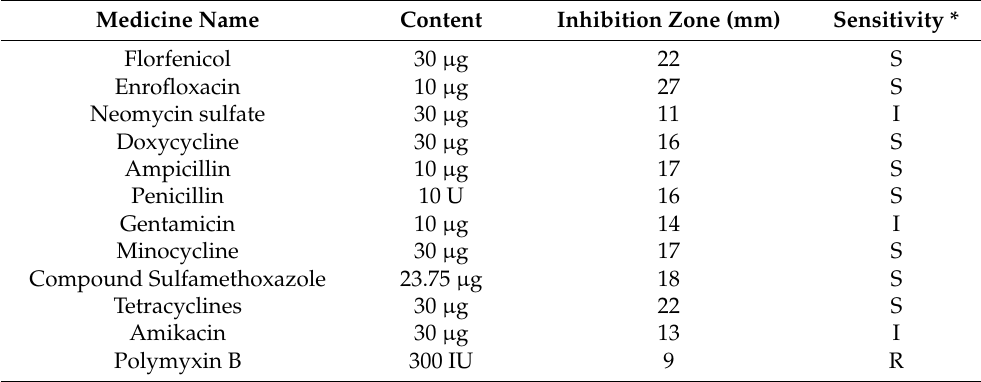
Table 2. Detection of drug sensitivity of the H-701 strain.